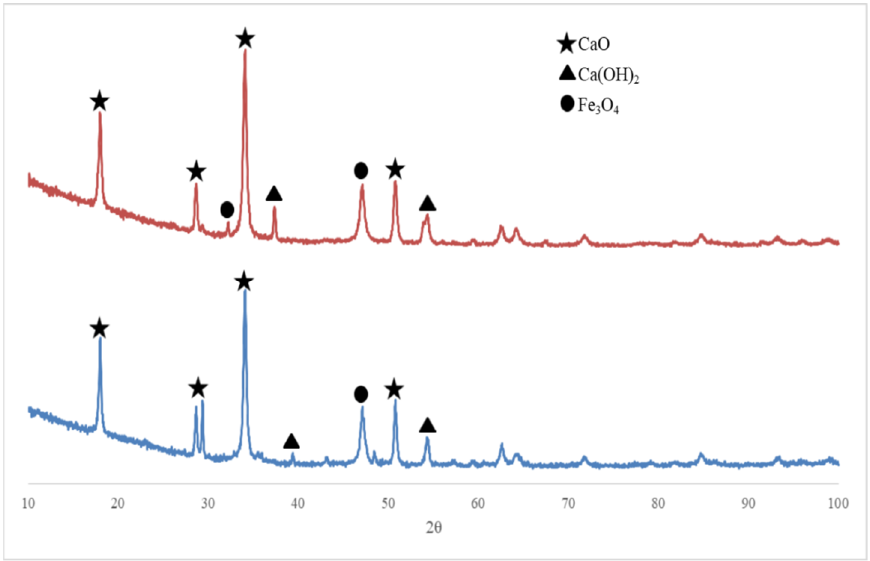
Figure 2. XRD pattern of prepared Fe 3 O 4 /CaO catalyst with the same dehydration time (3 h) at different dehydration temperatures of 600 °C and 700 °C, respectively.